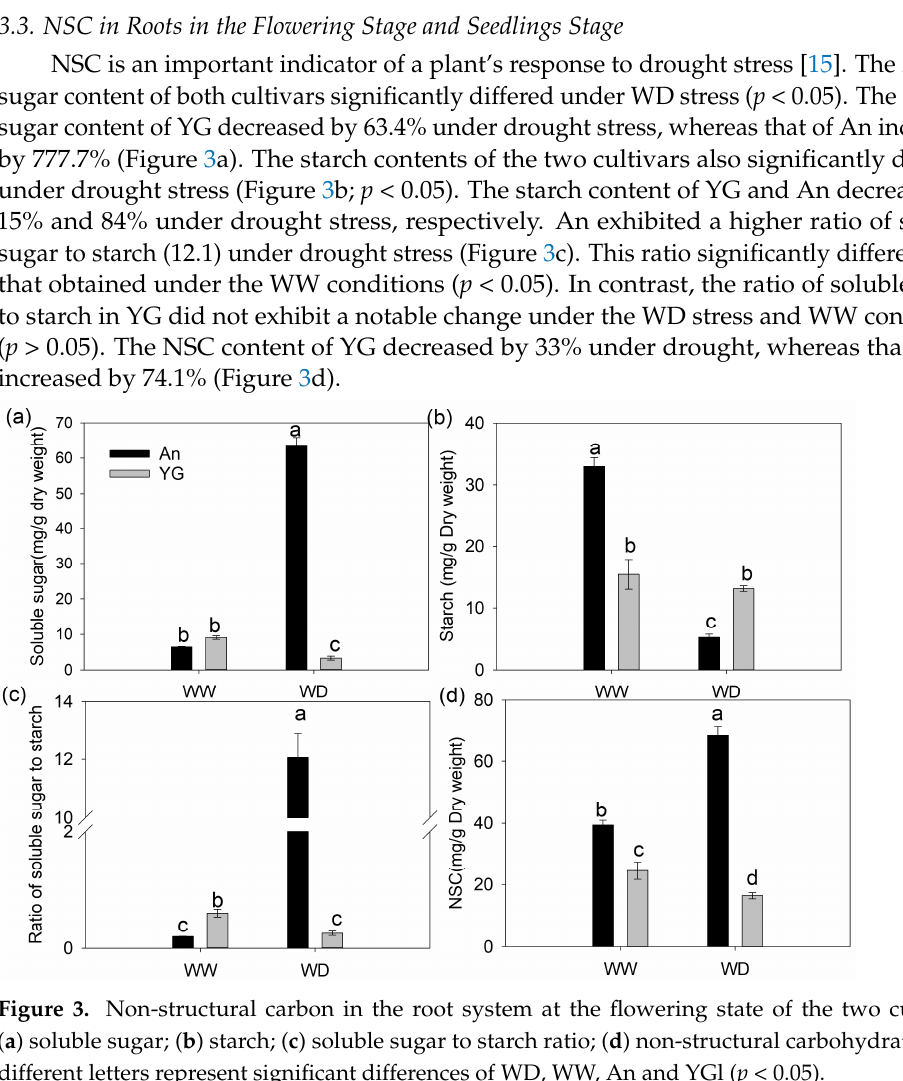
Figure 2. Effect of soil water status on the ( a ) root dry weight and ( b ) grain yield. The different letters represent significant differences of WD, WW, An and YG ( p < 0.05).